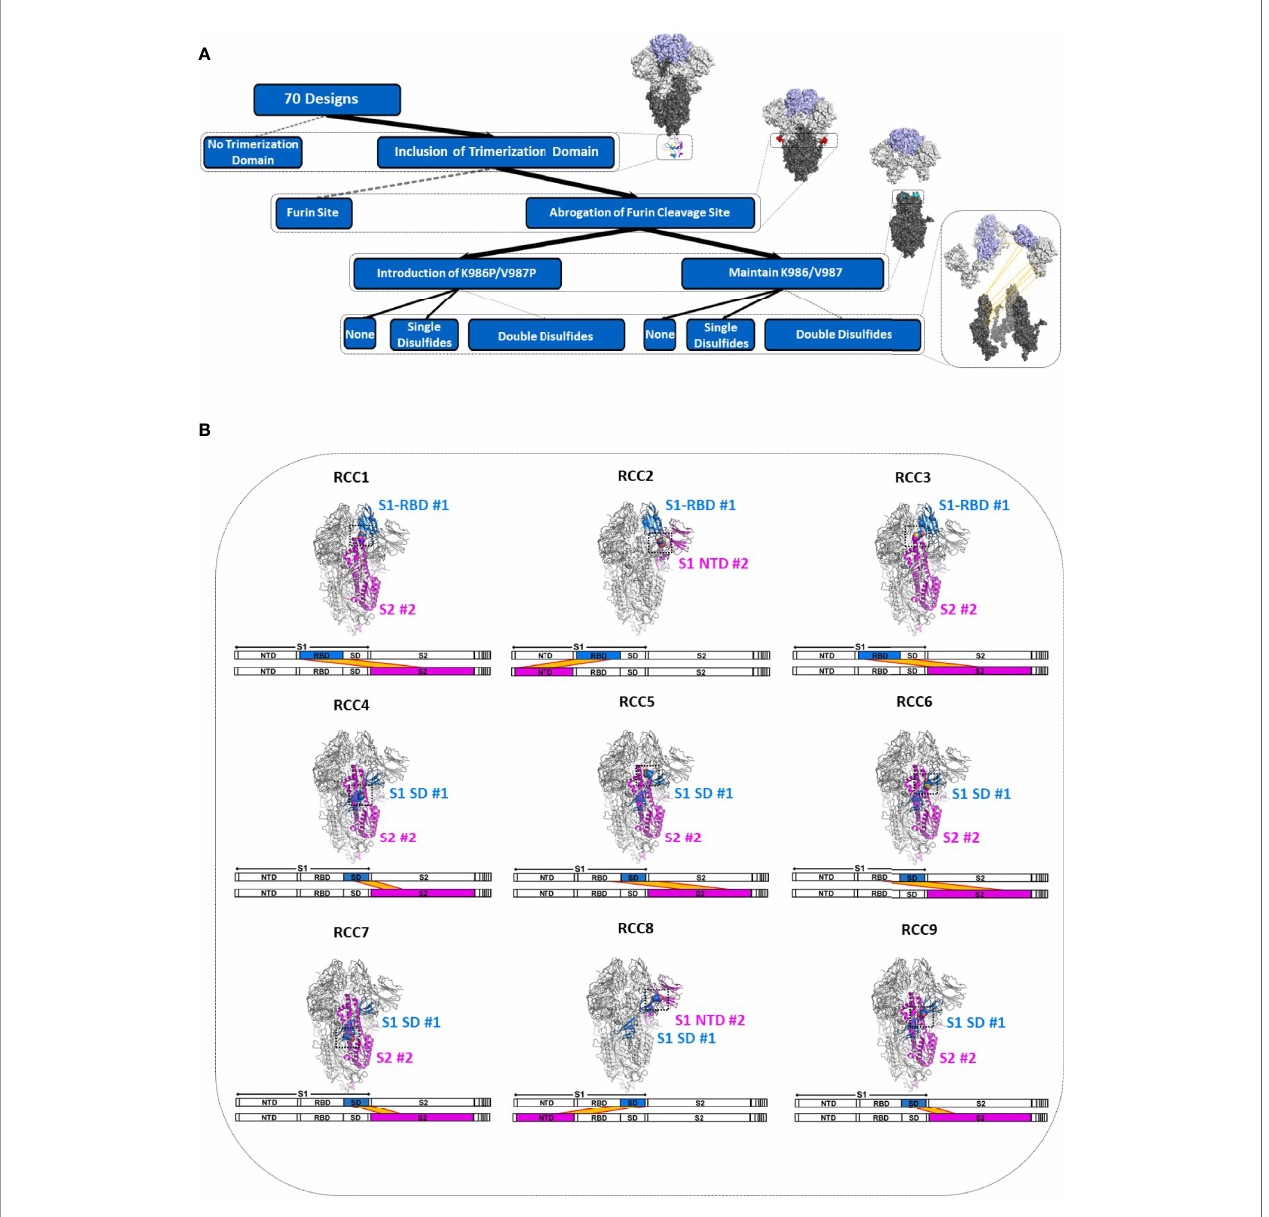
FIGURE 1 | Deconstruction of the SARS-CoV-2 Spike Trimer. Flowchart representation of the experimental variables in this study consisting of (top to bottom): trimerization domain, furin site, K986P/V987P prefusion locking mutations, and rationally designed disul fi des (A) . Structural models of each rationally designed disul fi de, with sequence maps shown below each model (B) . In (B) , engineered disul fi des are shown as spheres in each structural model, and the disul fi de-linked regions are indicated in each sequence map by a yellow